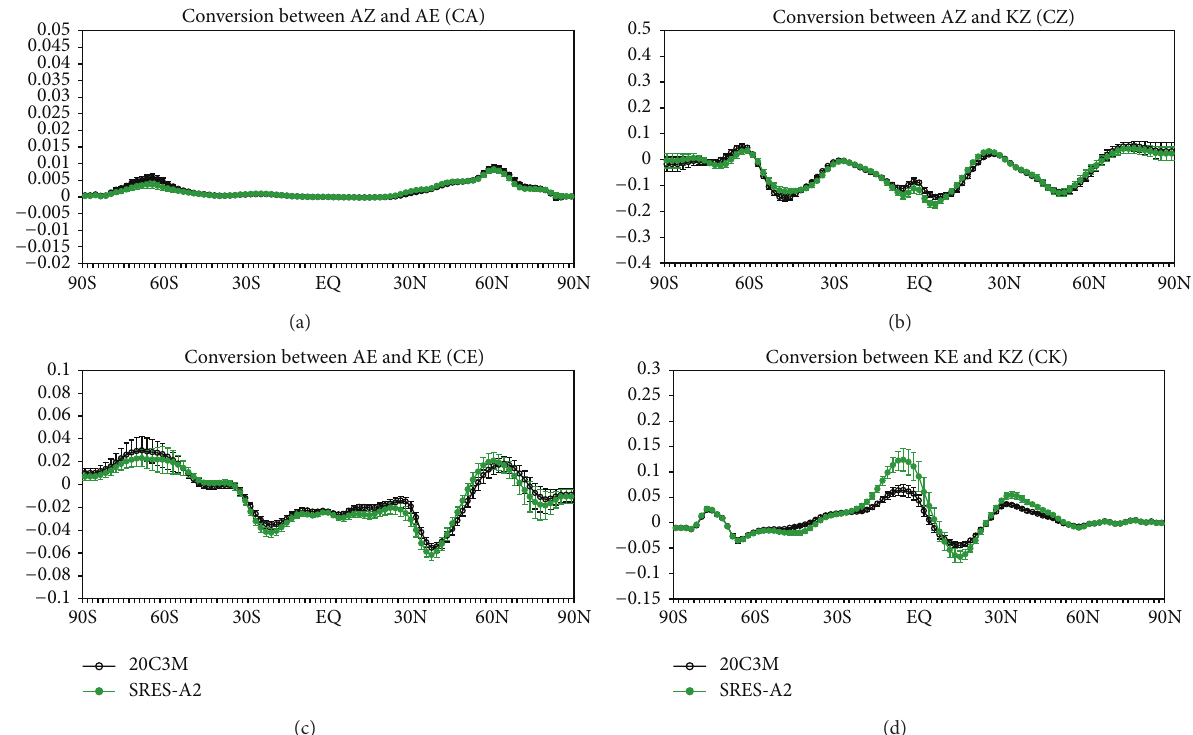
Figure 11: Annual latitudinal distribution of CZ (a), CA (b), CE (c), and CK (d) for the 20C3M and SRES-A2 periods from an ensemble of models. Error bars indicate 95% confidence intervals about the mean. Units are Wm −2